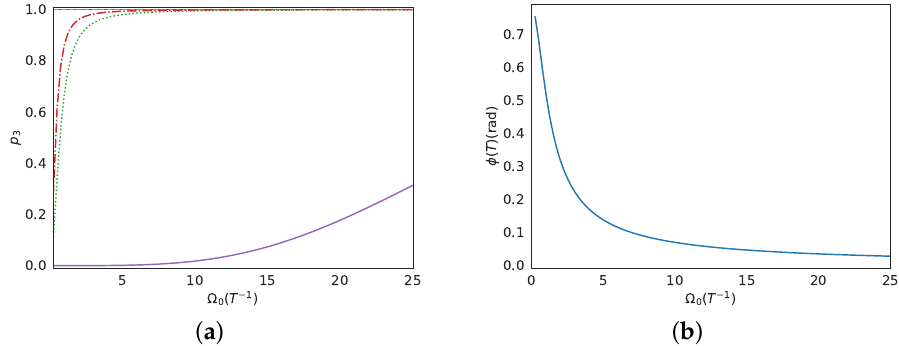
Figure 3. ( a ) The efficiency (final population p 3 ( T ) of level | 3 (cid:105) ) of the various shortcuts to diabaticity versus parameter Ω 0 , in the absence of noise. The shortcuts derived from polynomial θ ( t ) with constant (blue solid line) and ramp (orange dashed line) Ω ( t ) have a unit efficiency independent of Ω 0 , while the efficiency of the shortcut derived from Gaussian pulses (green dotted line) and its modification (red dashed-dotted line) increases gradually to unity with increasing Ω 0 . We also plot for reference the efficiency of the simple STIRAP method with Gaussian pulses (22) (purple solid line). ( b ) Final angle φ ( T ) versus Ω 0 for the shortcut derived from Gaussian pulses. Obviously, the boundary condition φ ( T ) = 0 is severely violated for smaller Ω 0 .